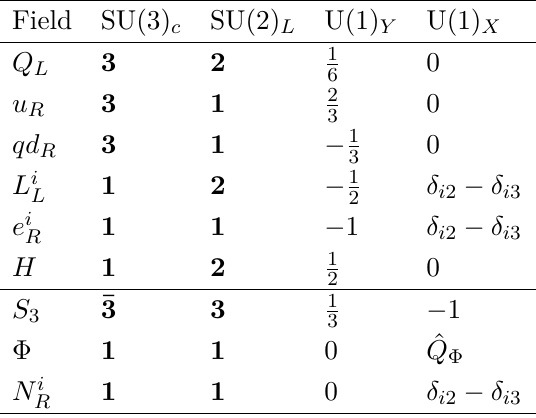
Table 1 . The field content of the charged leptoquark model. In addition to the SM fields, there is a U(1) X gauge field with flavour non-universal couplings to SM leptons, as well as an S 3 scalar leptoquark and a SM singlet Φ . Finally, including three right-handed neutrino fields N i a description of neutrino masses and mixing angles, which we comment on briefly in section